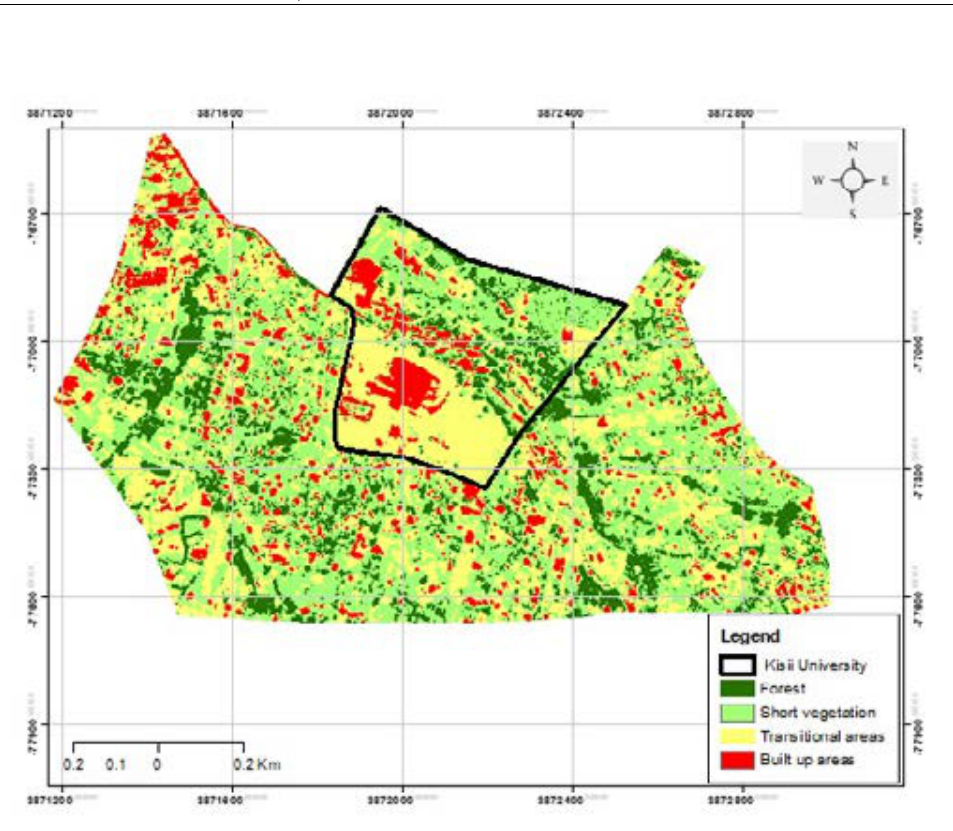
Fig. 2: Land use in 2005